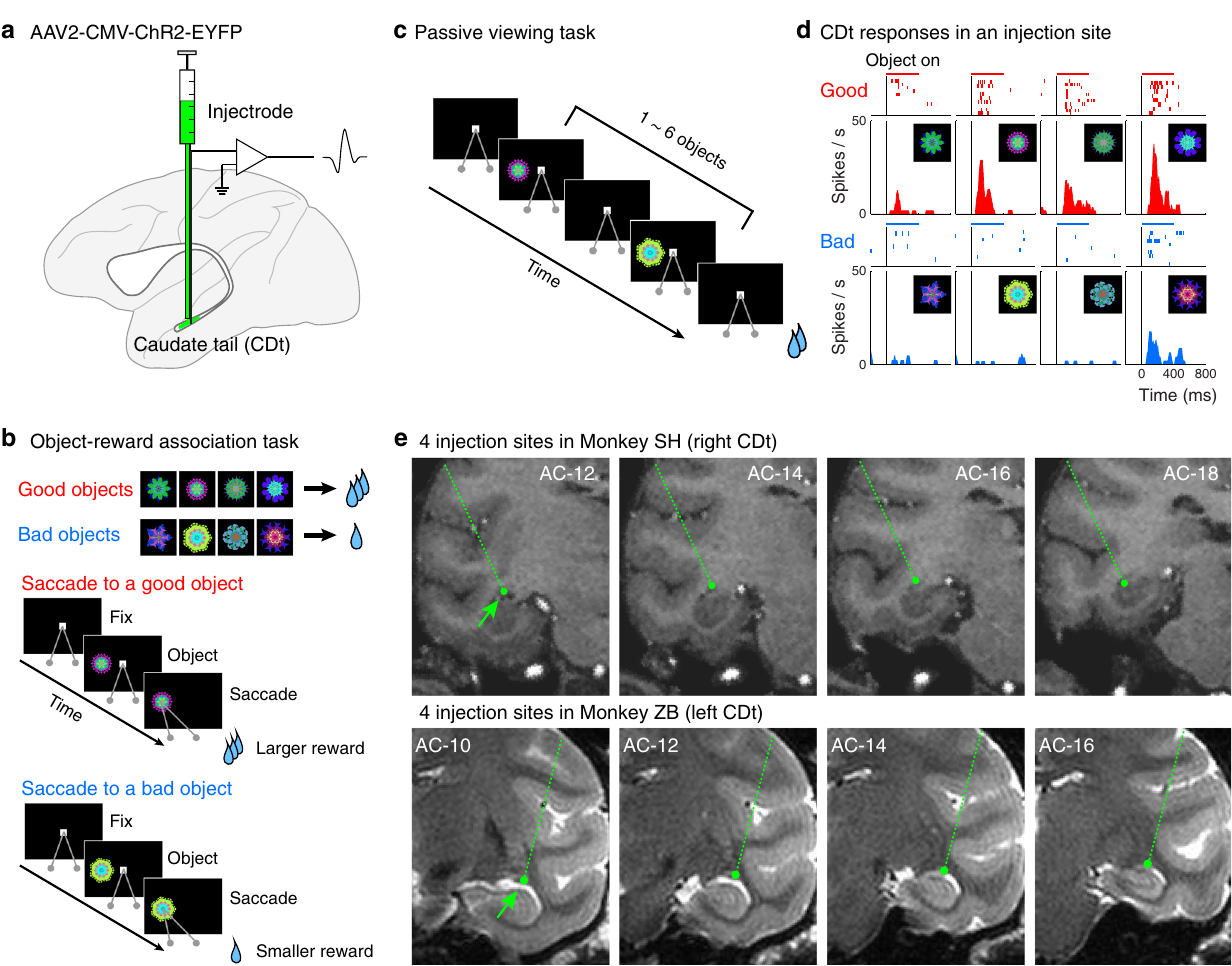
Fig. 1 Injection of ChR2 vector in stable value-coding CDt. a Viral vector was injected into CDt using an injectrode. Injection sites were guided by single- unit recording. b Object-reward association task. Eight fractal objects in a set were used in each session, four of which were associated with a larger reward (good objects) and four with a smaller reward (bad objects). Subjects made a saccade to a peripheral good or bad object after a center fi xation dot disappeared. After repeated learning, the subject chose good objects automatically in object free-viewing task 20 . c Passive viewing task. The same eight objects previously used in the object-reward association task were sequentially presented in a random order. Subjects were rewarded after fi xating a center dot until its disappearance irrespective of what objects appeared. d A representative neuron in an injection site in CDt showing stable object value signals. This neuron showed signi fi cantly higher response to good objects (top) than bad objects (bottom) ( P = 9.5 × 10 − 6 , Mann – Whitney U test, two-sided). Each raster plot indicates spike fi ring timings aligned to the presentation onset of each object. Each peri-stimulus time histogram (PSTH) indicates responses to each object. e Estimated injection sites on coronal planes of magnetic resonance images. Green dots indicate four injection sites in CDt for each subject. Green dotted lines show approaches to the injection sites. Top four panels: T1-weighted images of monkey SH; bottom four panels: T2- weighted images of ZB. Labels indicate slices 10, 12, 14, 16, and 18 mm posterior to the anterior commissure